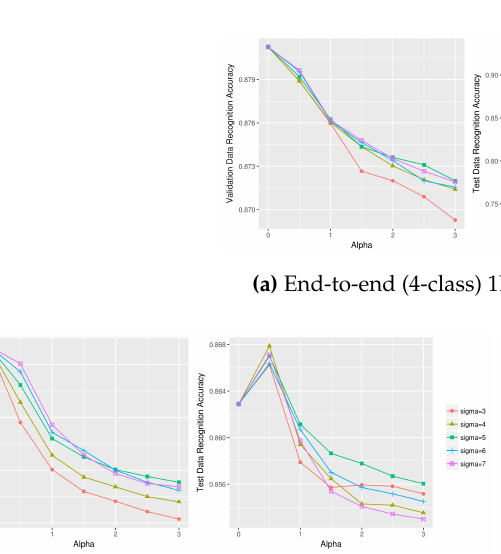
Figure 13. Stand vs. walk recognition accuracy using different ( σ , α ) combinations on upper body OPPORTUNITY dataset ( left : validation data, right : test data).